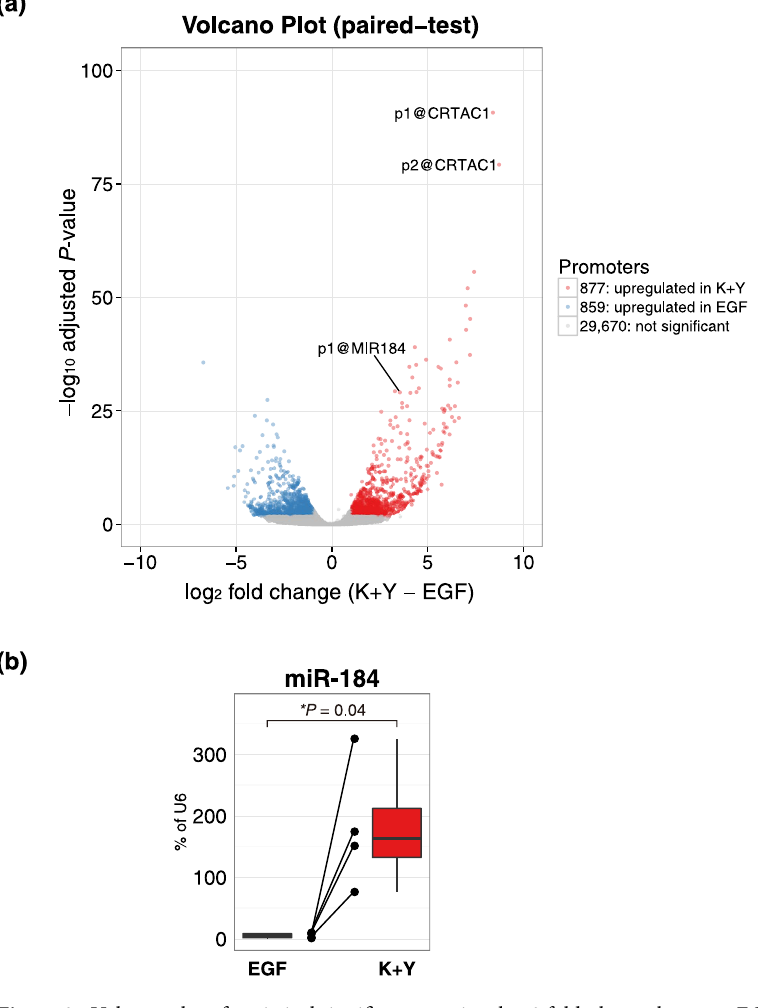
Figure 3. Volcano plot of statistical significance against log 2 fold-change between EGF-treated LECs and K + Y-treated LECs. (a) Promoters highly expressed in LECs cultured with EGF are shown in blue (adjusted P < 0.01. log 2 fold-change <− 1), and promoters highly expressed in LECs cultured with K + Y are shown in red (adjusted P < 0.01. log 2 fold-change > 1). Promoters that were not differentially expressed between these two culture conditions are shown in gray. The most differentially expressed promoters were p1@CRTAC1 and p2@ CRTAC1, which were quite highly expressed in K + Y. The promoter of CEC-specific miR-184 was also highly expressed in LECs cultured with K + Y. K + Y: KGF and Y-27632. (b) Expression level of miR-184 quantified by RT-PCR. Each dot represents the expression level in each sample, and each line indicates binding to samples from the same donors. An asterisk represents statistical